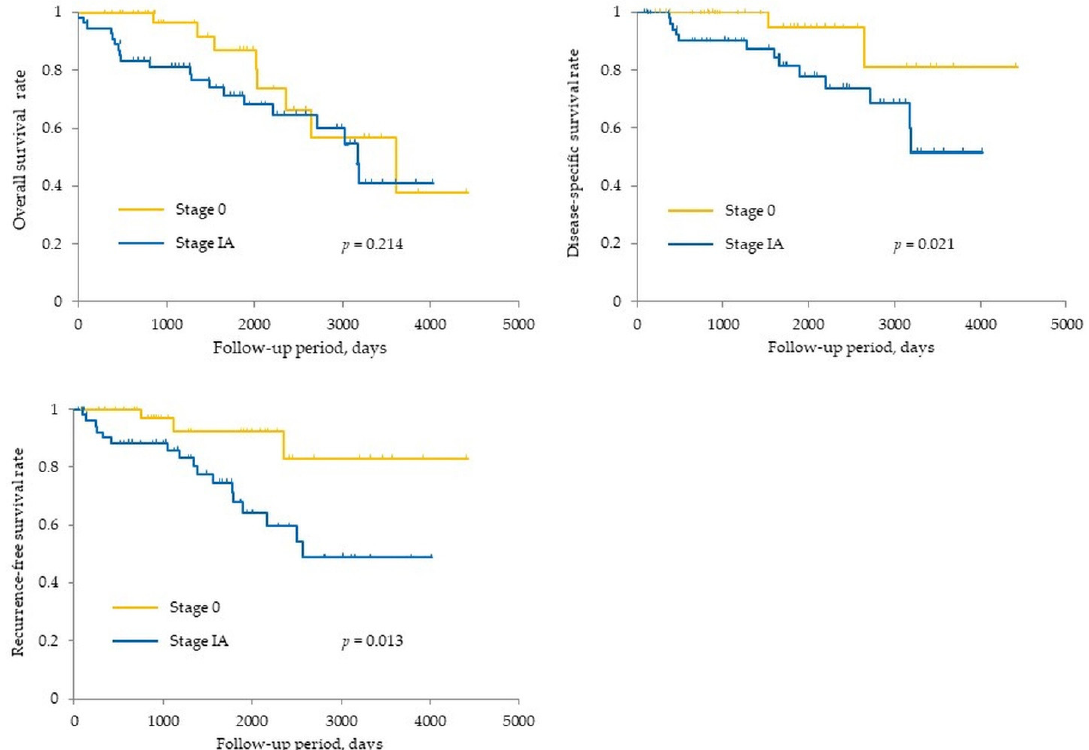
according to the Figure 1. Kaplan–Meier method estimates of overall survival, disease-specific survival, and recurrence-free survival ac- cording to the stages.